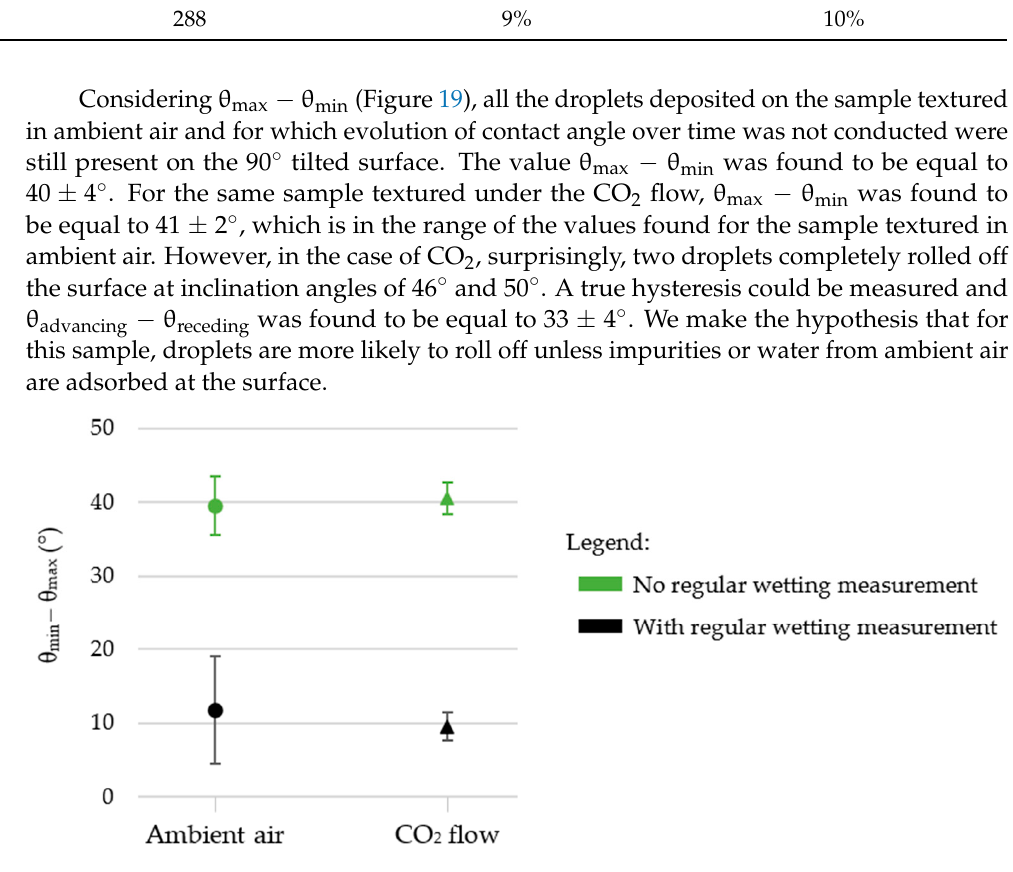
Figure 19. The θ max − θ min values for samples textured in ambient air or under a CO 2 flow for which the square pillars’ top was not irradiated, and for which regular wetting measurements were (in black) or were not (in green) conducted over time.